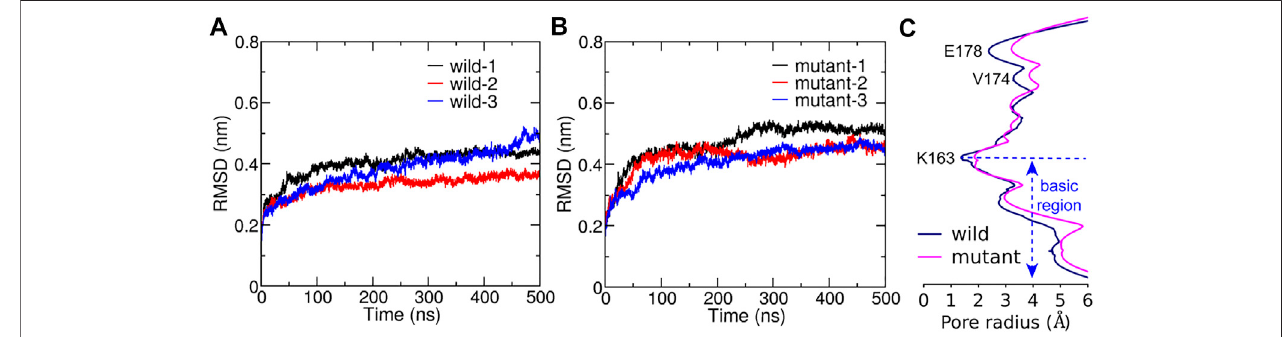
FIGURE 2 | The structural stability during simulations and the average pore radius after reaching equalibrium. C α -RMSD of the WT (A) and the L210F mutant (B) . Threetrajectoriesarerepresentedinred,blueandblack,respectively. (C) Theaverageporeradii.TheaverageporeradiifortheWTandtheL210Fmutantwereobtained bycalculatingtheporeradiusoftheaveragestructuresobtainedfromthelast200 nsofallofthethreetrajectoriesforeachprotein.Hole2.0(Smartetal.,1996)wasused to calculate the radius with all the hydrogen atoms removed in the